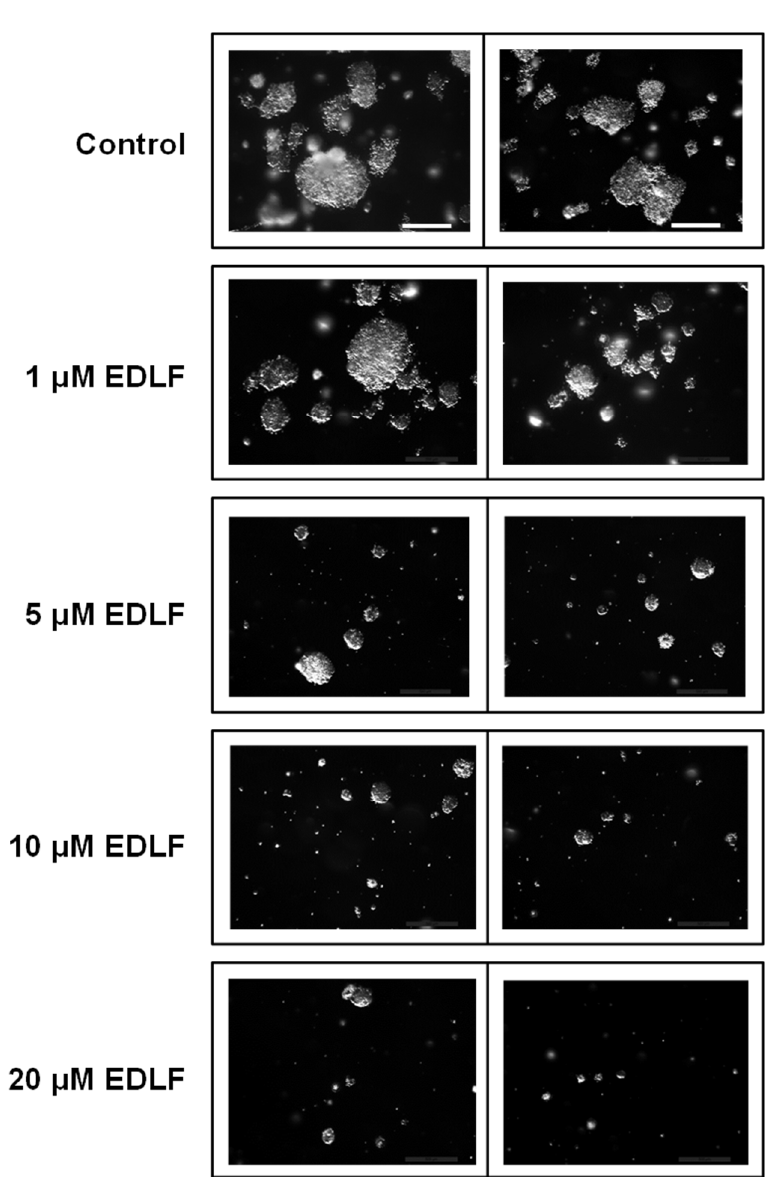
Figure 3. Effect of edelfosine on the formation of PANC-1 CSC pancreatic cancer spheroids. Disaggregated CSCs from PANC-1 CSC pancreatic cancer spheroids were assayed for the formation of colonies in soft agar analysis in the absence and in the presence of different concentrations of edelfosine (EDLF). Bar, 600 μ m. The data are representative of at least three independent experiments.